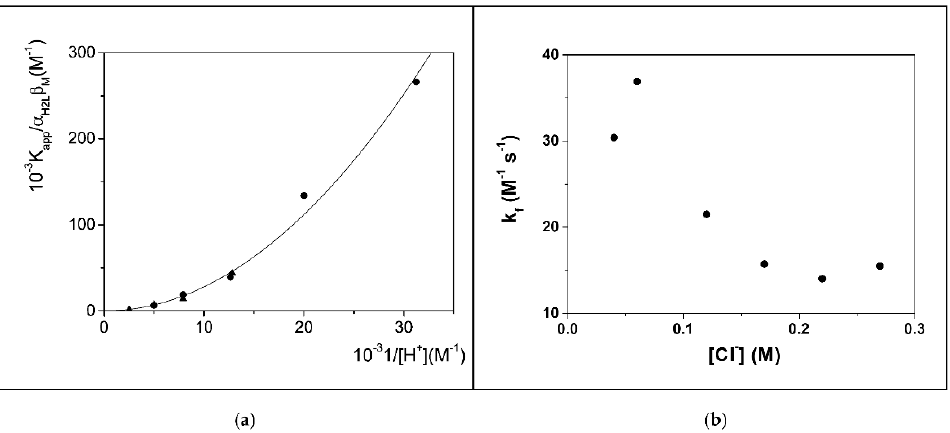
Figure 8. ( a ) Dependence of the apparent equilibrium constant K app on the acid concentration at 25 °C for the Ga 3+ /8-hydroxyquinoline system in the presence of SDS 0.02 M; (circles) data from spec- trophotometric titrations; (triangles) data from kinetic measurements (k f /k d ). Figure adapted with permission from reference [86]. Copyright 2008 American Chemical Society. ( b ) Dependence of the forward-binding rate-constants on the Cl − concentration for the Au 3+ -PADA system; C DTAC = 0.02 M, pH 6, 25 °C. Figure adapted with permission from reference [87]. Copyright 2015 Elsevier.